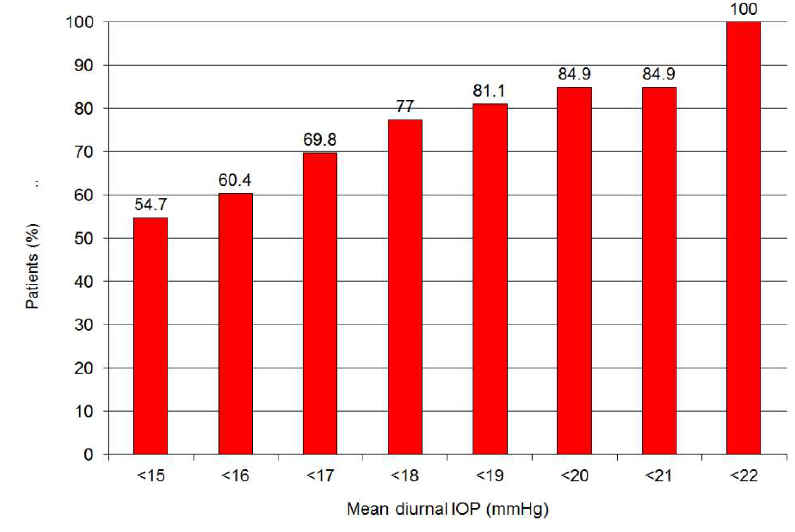
Figure 7. Qualified success rate after 48 months of follow-up.